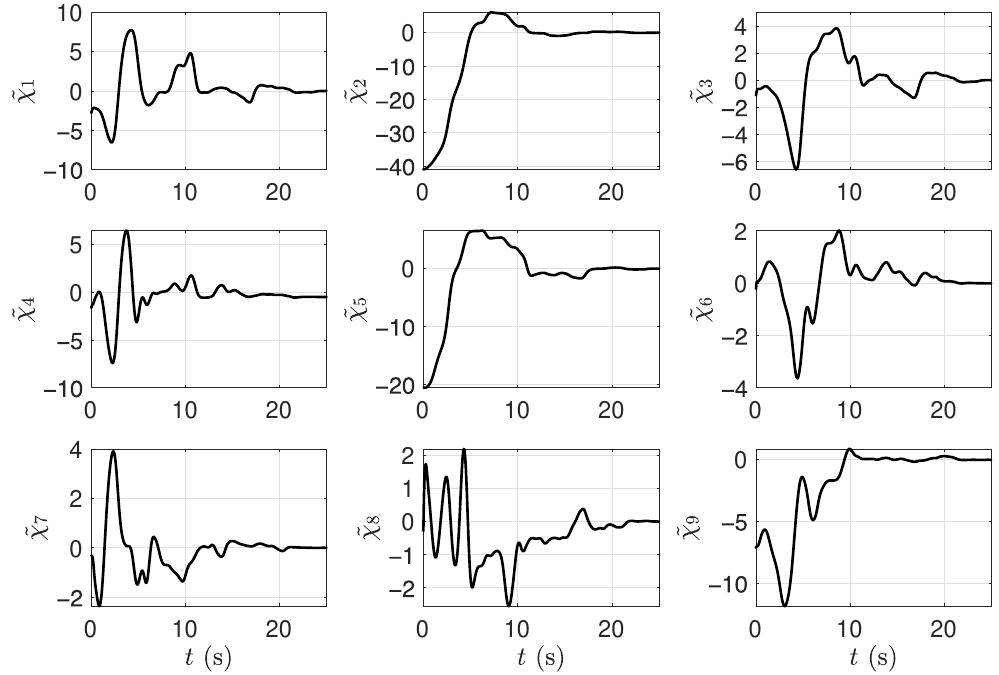
Figure 4. LLRR vector parameters error ˜ χ during the estimation